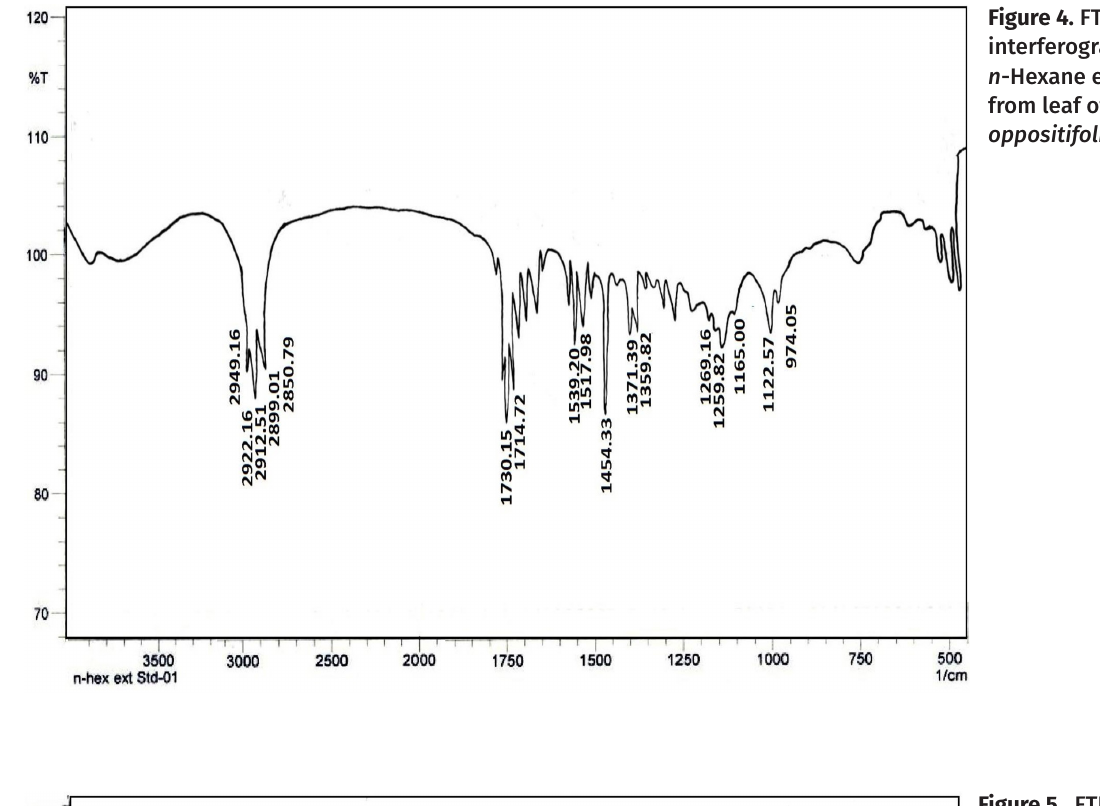
Figure 5. FTIR interferogram of n -Hexane extract from stem of C.